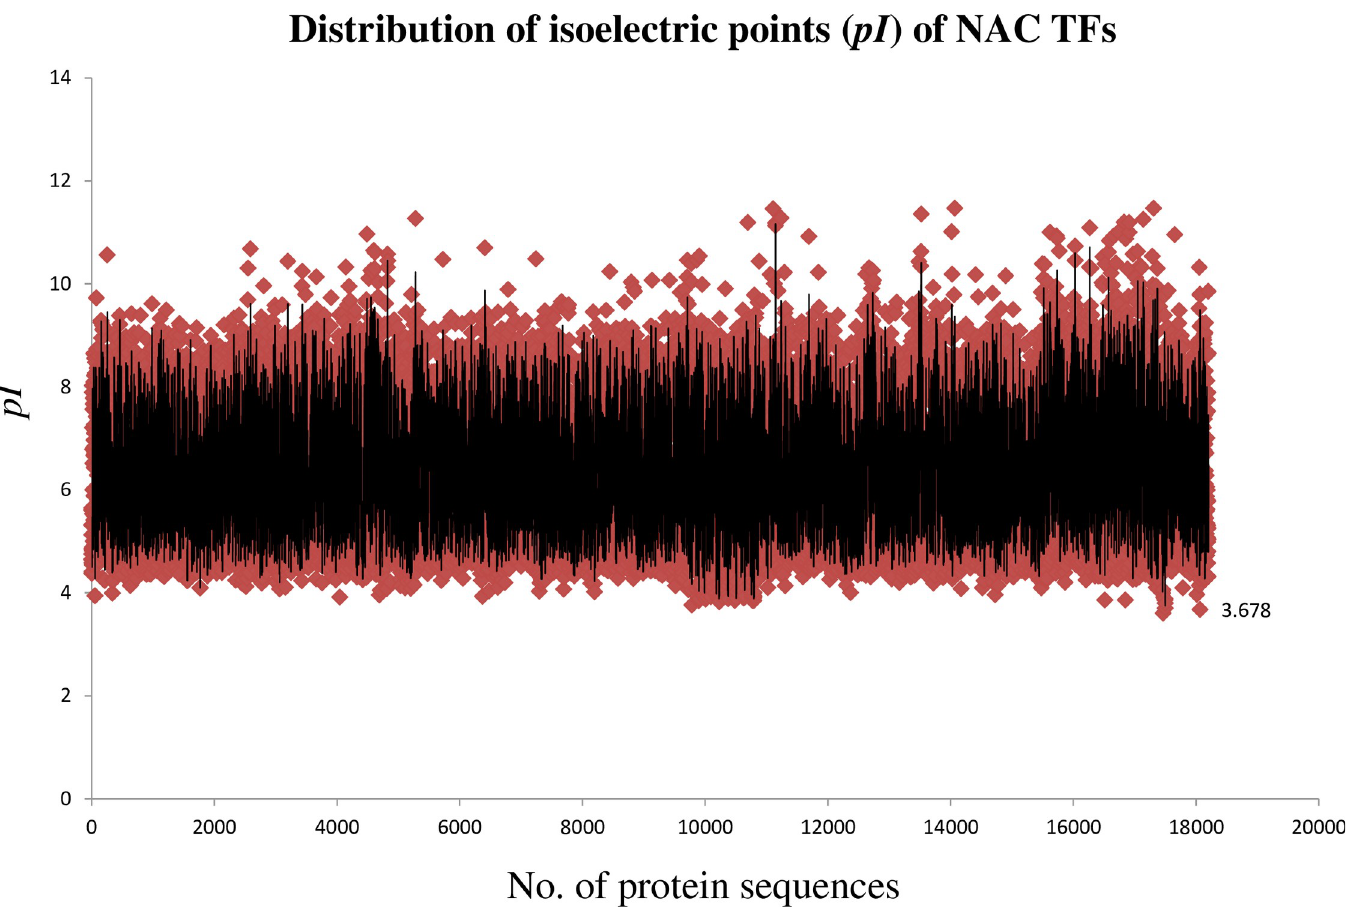
Fig 2. The distribution of the isoelectric point of NAC TFs. The isoelectric point of NAC TFs ranged from pI 3.78 (OB07G17140.1, Oryza brachyantha ) to pI 11.47 (Sevir.3G242500, Setaria viridis ). The average isoelectric point of NAC TFs was 6.38. A total of 17158 NAC TFs were utilized in the analysis of the pI of NAC TFs. The analysis of pI was conducted using a protein isoelectric point calculator (http://isoelectric.org/).